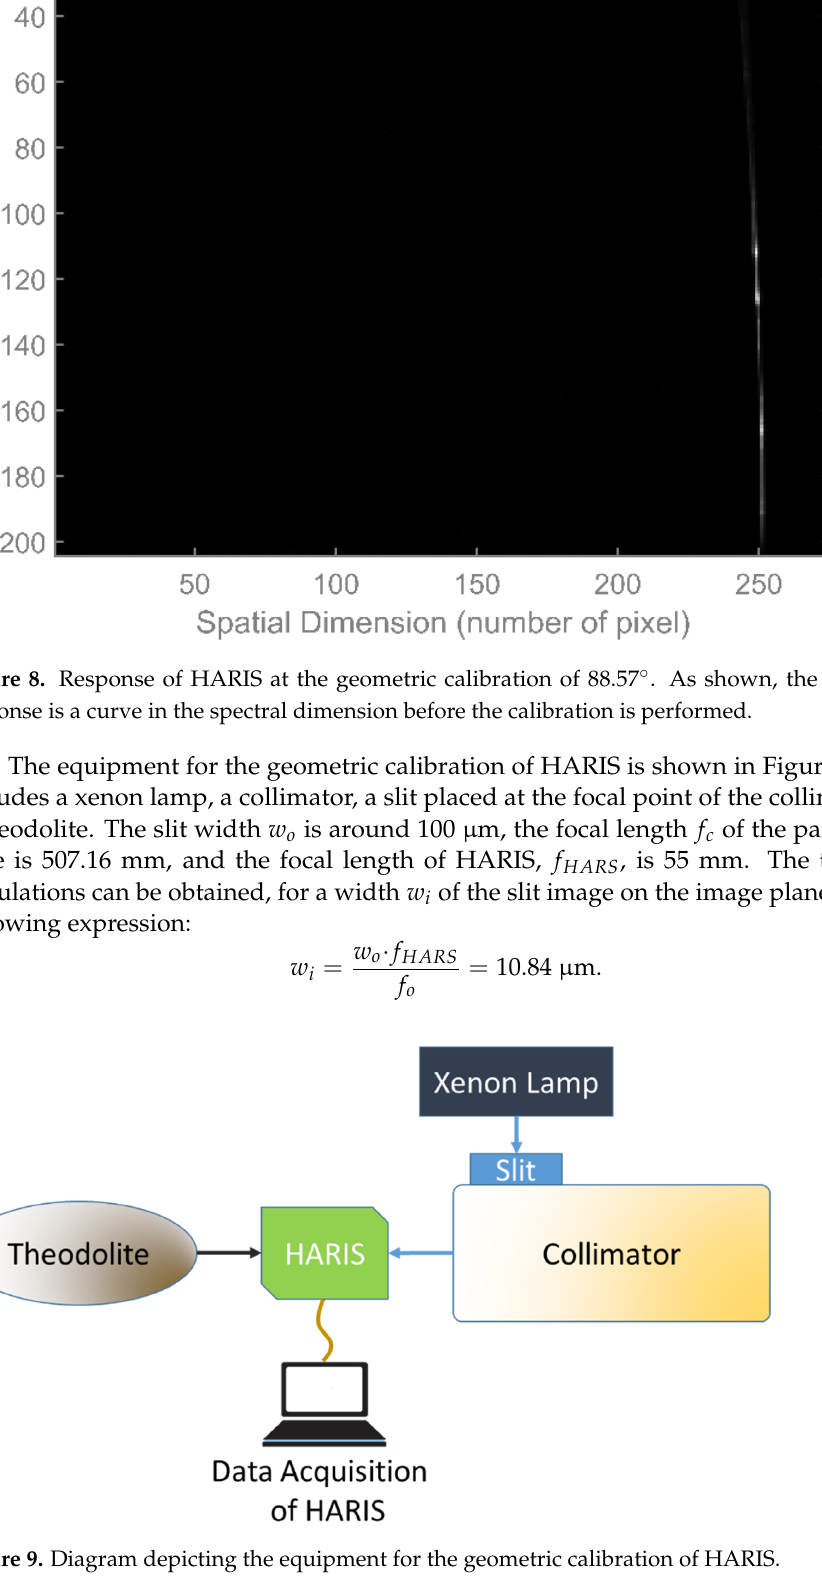
Figure 9. Diagram depicting the equipment for the geometric calibration of HARIS.